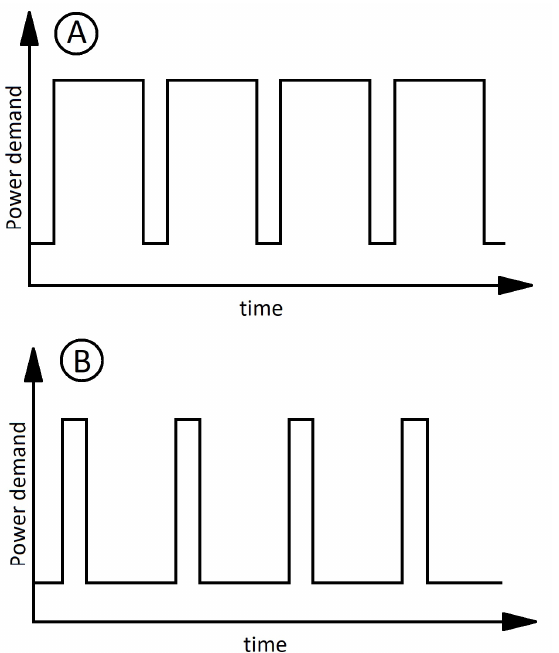
(cid:13) , operational profile characterized by short